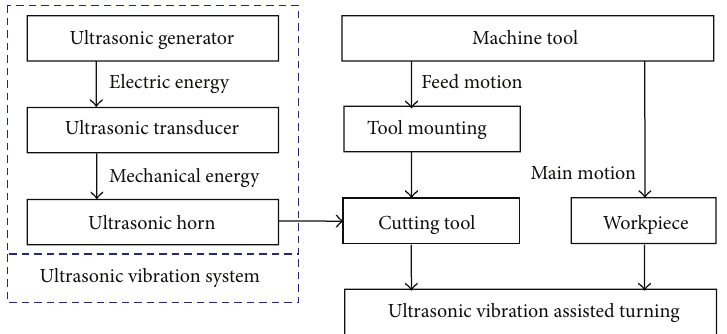
Figure 2: Structure and working principle diagram of MS-UAT.